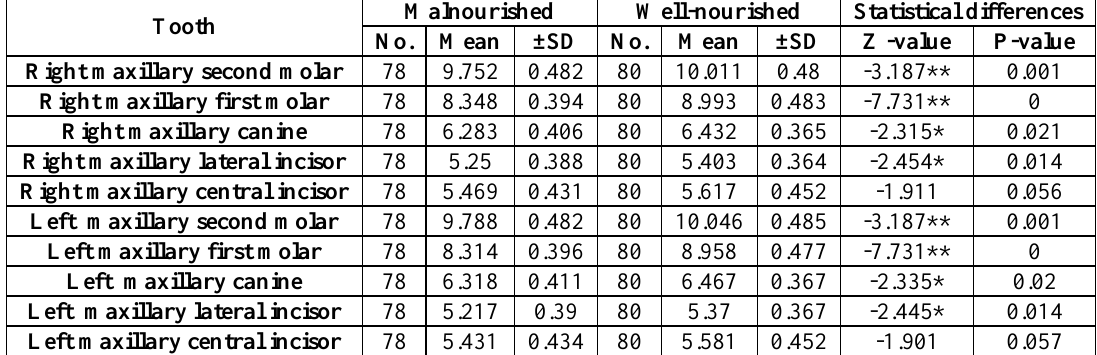
Table 1: Measurement of mesiodistal diameters (mm) of maxillary teeth in malnourished and well-nourished group among children aged 5 years by gender. Malnourished Well-nourished Statistical differences Tooth No. Mean ±SD No. Mean ±SD Z -value P-value Right maxillary second molar 78 Right maxillary first molar Right maxillary canine Right maxillary lateral incisor Right maxillary central incisor Left maxillary second molar Left maxillary first molar Left maxillary canine Left maxillary lateral incisor Left maxillary central incisor Table 2: Measurement of mesiodistal diameters (mm) of mandibular teeth in malnourished and well-nourished group among children aged 5 years by gender. Malnourished Well-nourished Statistical differences Tooth No. Right mandibular second molar Right mandibular first molar Right mandibular canine Right mandibular lateral incisor Right mandibular central incisor Left mandibular second molar Left mandibular first molar Left mandibular canine